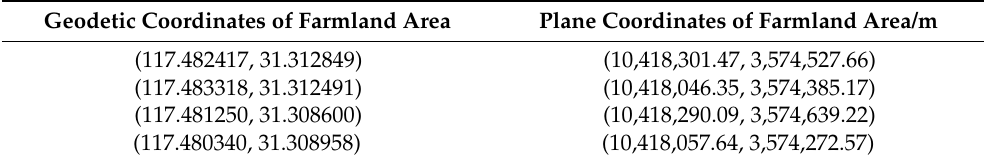
Table 1. Geodetic and plane coordinates of farmland area. Geodetic Coordinates of Farmland Area Plane Coordinates of Farmland